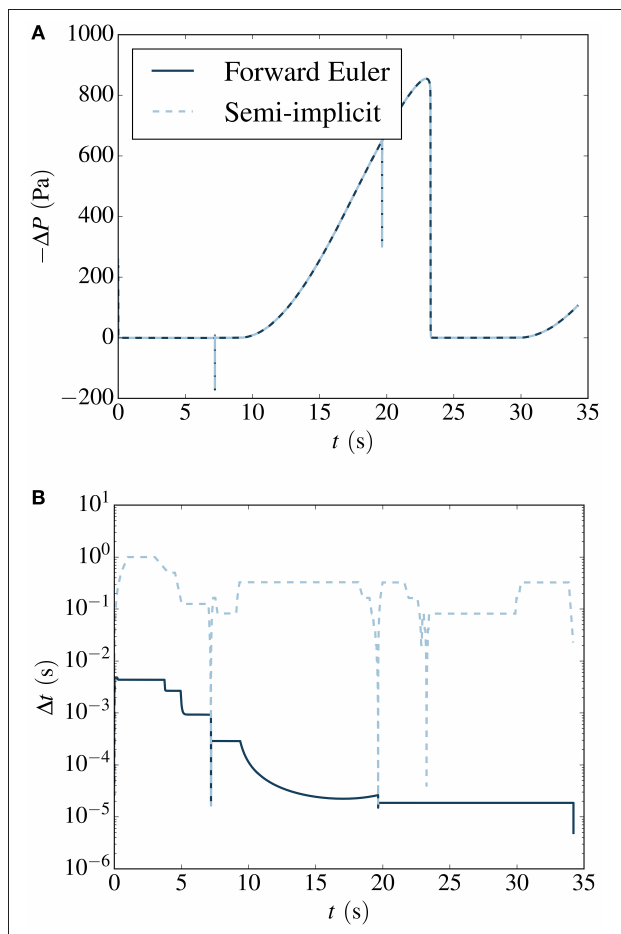
FIGURE 10 | (A) Pressure difference required to drive the flow at Q = 10 − 11 m 3 s − 1 , corresponding to Ca = 1.2 · 10 − 7 , in the Haines jump case. Results are plotted for the forward Euler method (solid dark blue) and the semi-implicit method (dashed light blue). These lines coincide at the scale of representation. The time steps lengths used by each method are plotted in (B)